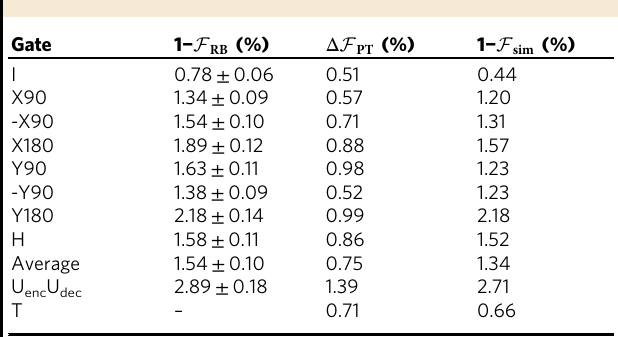
Table 1 Operation fi delities Gate